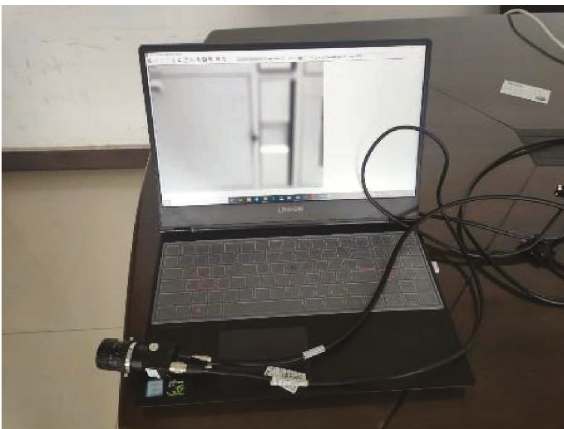
Figure 1: Laboratory test device for the segmentation.